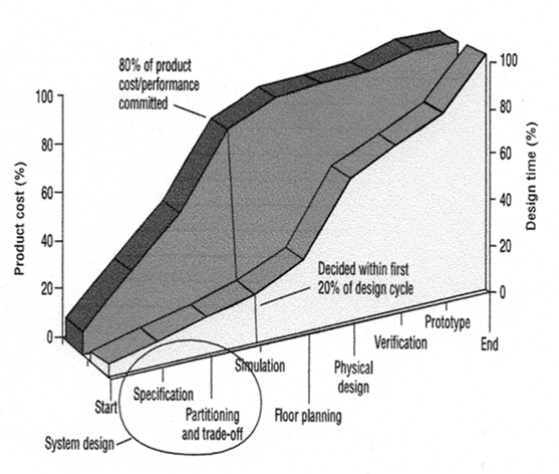
Figure 1. The first cycle of system design should focus on cost, performance, size, power dissipation and system reliability [7].